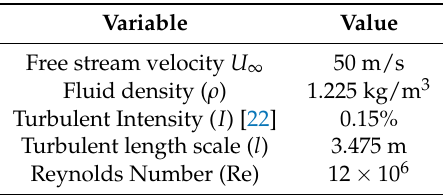
Table 2. Setup of the